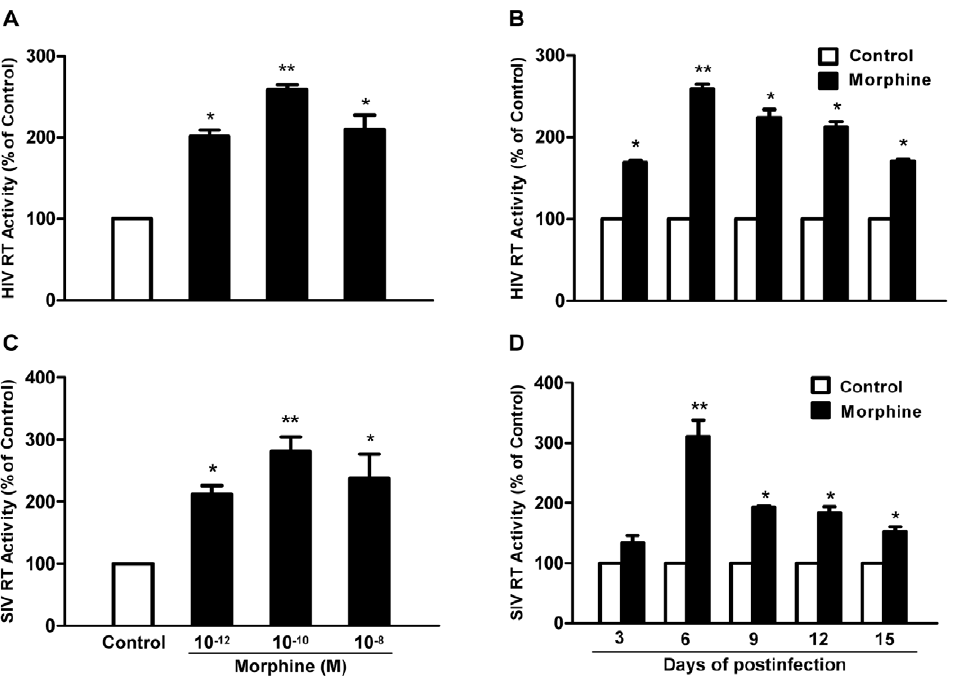
Figure 3. Dose-dependent and time-course effects of morphine on AIDS virus replication. A and C: Dose-dependent effect of morphine on HIV or SIV replication. Seven-day-cultured macrophages were treated with or without morphine at indicated concentrations for 24 h and then incubated with HIV Bal or SIV Delta B670 strain for 2 h in the presence or absence of morphine. Day 6 culture supernatant was collected for HIV (A) or SIV (C) RT assay. B and D: Time-course effect of morphine on HIV or SIV. Seven-day-cultured macrophages were treated with or without morphine (10 2 10 M) for 24 h prior to infection with HIV Bal strain or SIV Delta B670 strain for 2 h and then cultured for 15 days. HIV (B) or SIV (D) RT activity was determined in cultured supernatants at indicated time points postinfection. Data are expressed as HIV or SIV RT activity in morphine-treated cells (percentage of control) compared with those in untreated cells. The results represent the mean 6 SD of three independent experiments using macrophages from three different donors. Statistical analysis was performed by one-way analysis of variance (A, C) or Student’s t-test (B, D), and significance is shown morphine versus control with * (P , 0.05) and ** (P , 0.01).